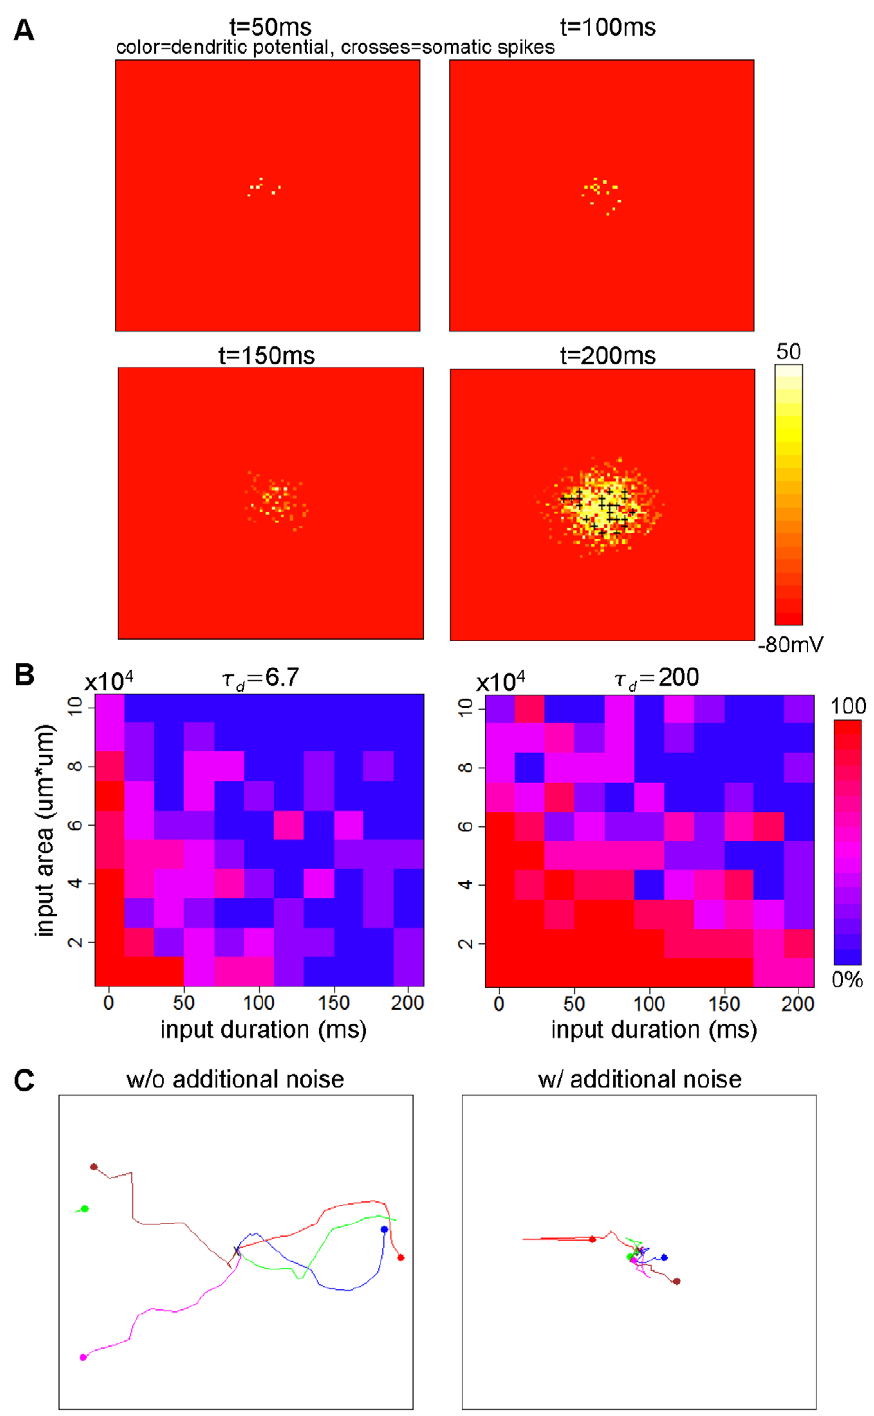
Figure 9. Expansion of the time window for spatio-temporal integration at network level. (A) The process of input integration. The history of the input to dendrites is stored as the dendritic plateaus and sufficient occurrences of dendritic plateaus cause the generation of clustered somatic action potentials (bump). The input duration and input area are 200 ms and 20000 m m 2 , respectively. (B) The success rate of the integration to generate a bump is plotted versus the input duration and input area for the non-plateau ( t d ~ 6 : 7 ms, left) and long-lasting plateau ( t d ~ 200 ms, right) cases. The long-lasting dendritic plateau expands the time window for the integration. (C) The trajectory of the center of the bumps with long- lasting dendritic plateau ( t d ~ 200 ms). External noisy currents after the generation of bumps can immobilize the bumps (right), while the bumps move in noiseless background conditions (left). The different colors indicate different trials.